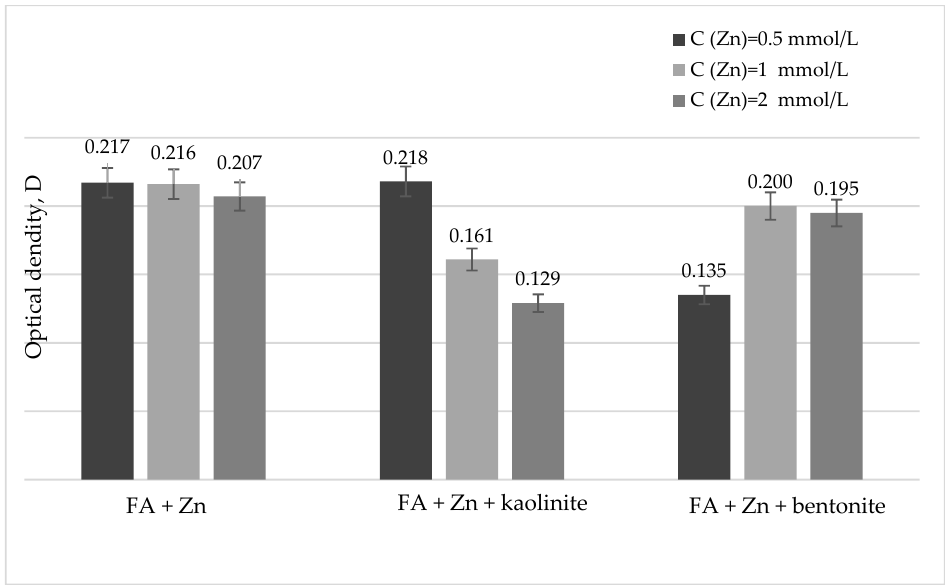
Figure 4. Dependence of the optical density of the studied systems on the Zn 2+ concentration.